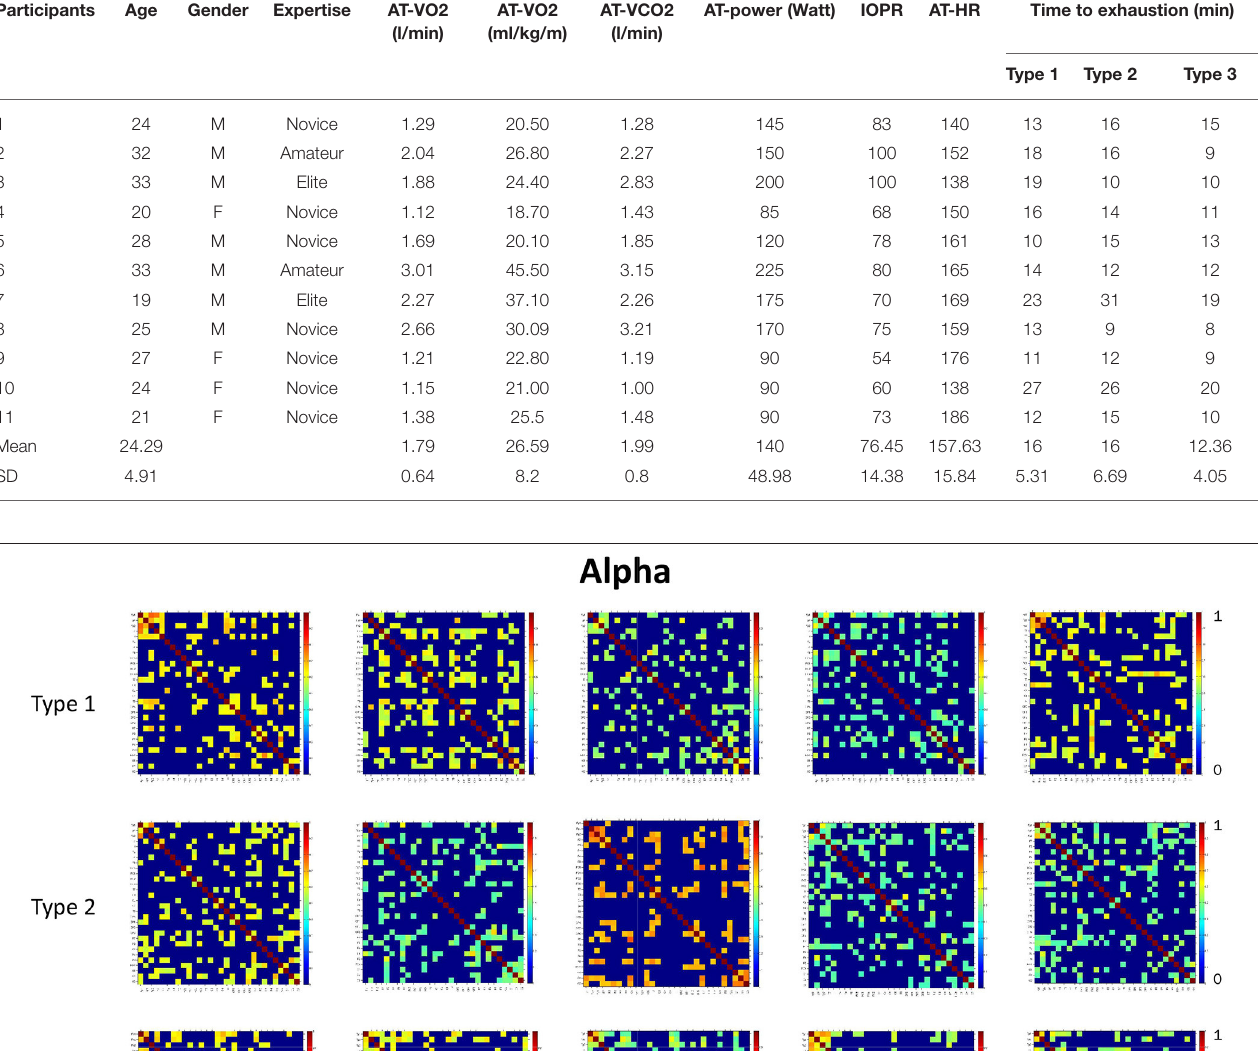
TABLE 1 | Mean (M) and Standard Deviations (SD) of Anaerobic Threshold (AT) and Individual Optimal Pedaling Rate (IOPR) obtained with incremental test, and minutes on constant load phase of Time to Exhaustion Test (TTE) in the three types of performance for the participants.